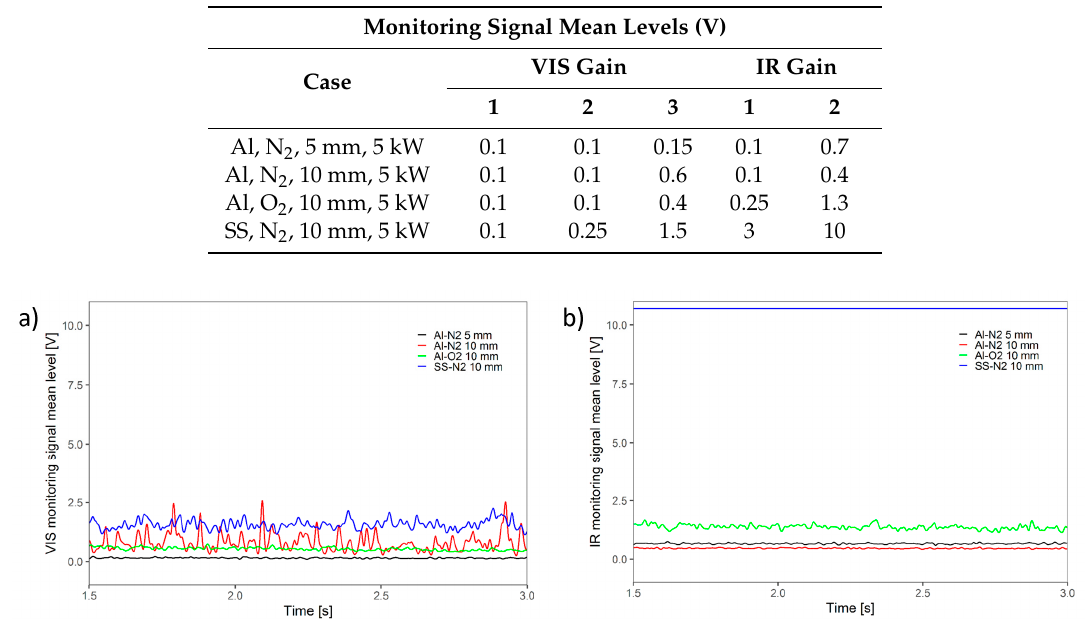
Table 3. Signal monitoring values for different visible spectrum (VIS) and IR gains at ideal process parameters (Table 1). For 5 mm-thick aluminum, gain 4 was also tested with the same results as gain 3.